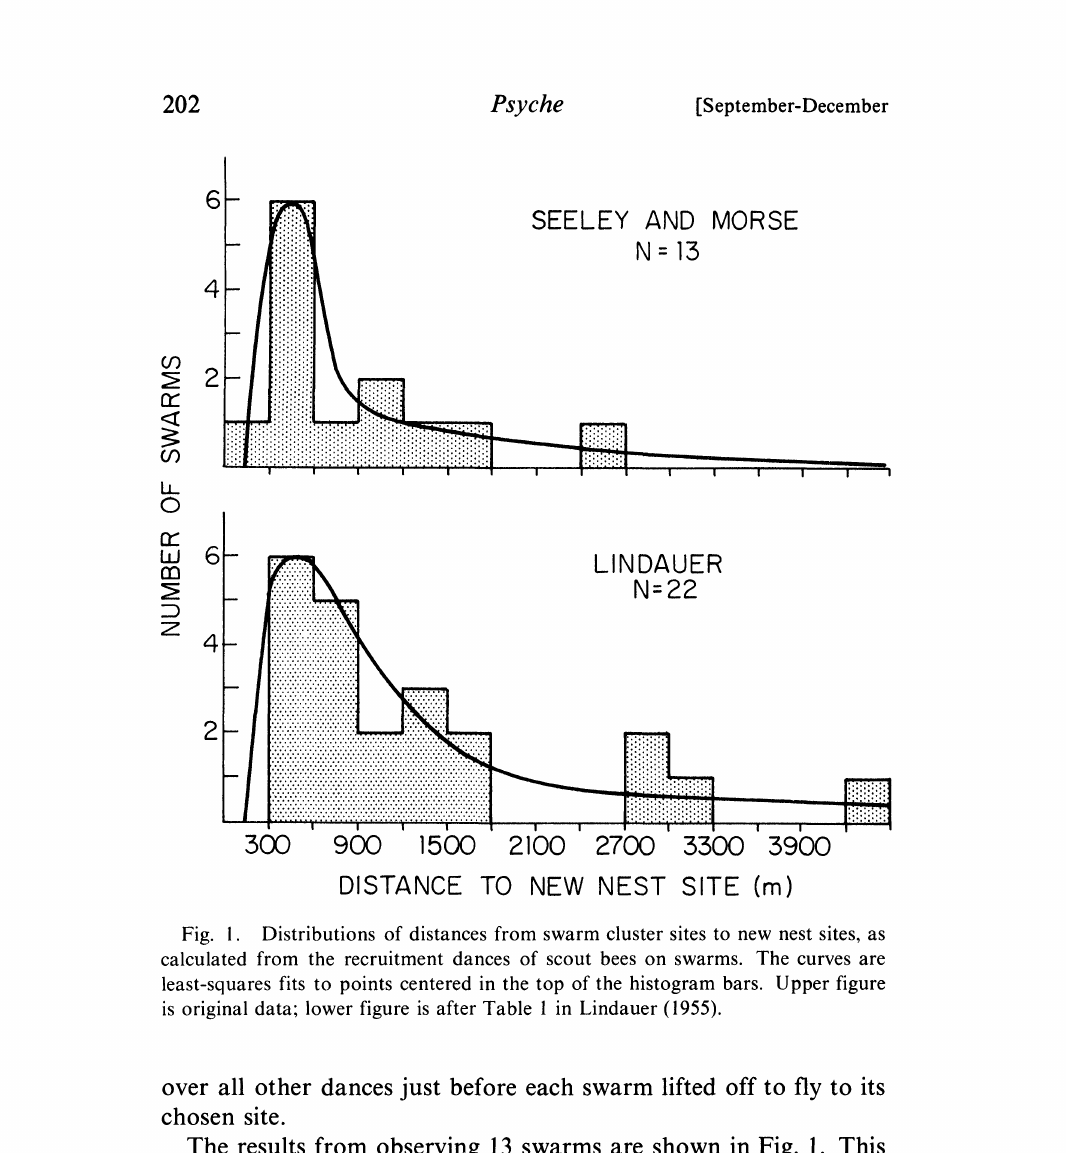
Fig. 1. Distributions of distances from swarm cluster sites to new nest sites, as calculated from the recruitment dances of scout bees on swarms. The curves are least-squares fits to points centered in the top of the histogram bars. Upper figure is original data; lower figure is after Table in Lindauer